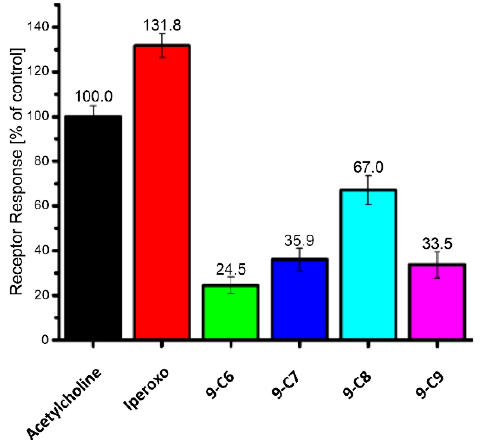
Figure 7. Evaluation of the Iperoxo/Naphmetonium hybrid ligands 9-Cn at the M 2 muscarinic FRET receptor sensor stably expressed in HEK293 cells [13].